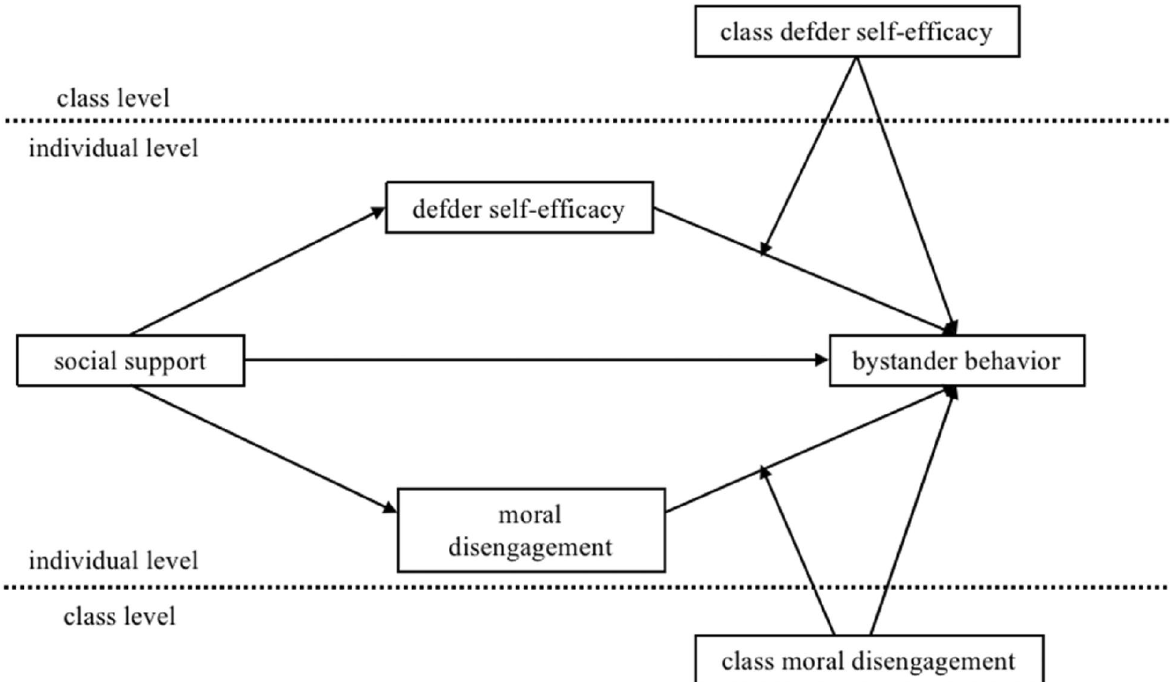
Fig. 1 Conceptual multilevel moderated mediation